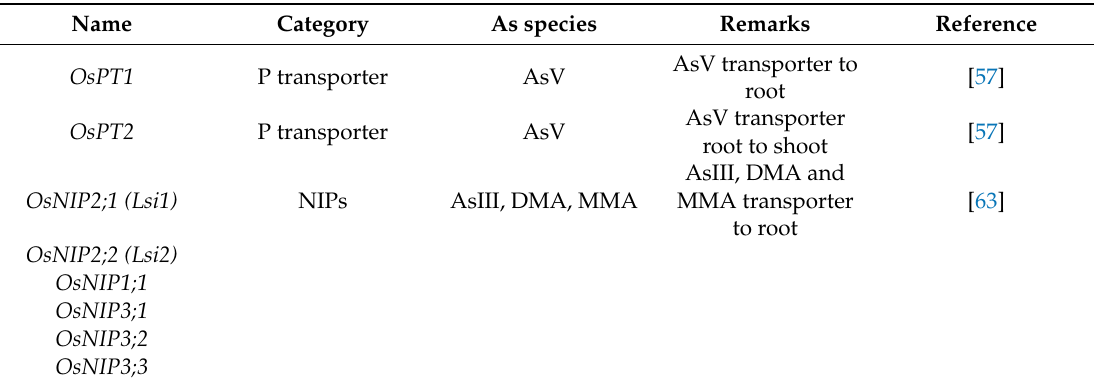
Table 2. Gene families involved in As uptake, transport and metabolism in